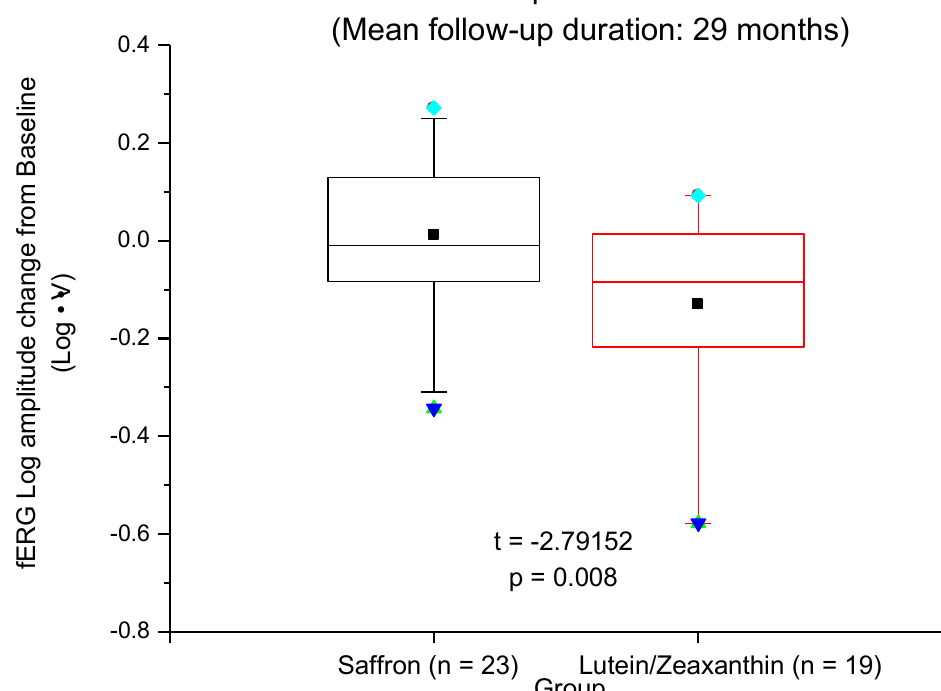
Figure 7. fERG Log amplitude change from baseline is reported for two groups of patients treated either with Saffron or Lutein/Zeaxanthin. Box plots showing the mean (closed squares), median (horizontal line), interquartile range (box), upper and lower 95% percentiles (error bars), upper and lower 99% percentiles (blue square and triangle, respectively) of the distribution of the fERG log amplitude changes from baseline in Saffron- and Lutein/Zeaxanthin-treated AMD patients. The difference between the two groups was highly significant (independent t -test)